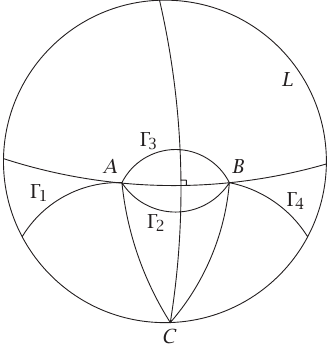
Figure 7.2 . Cutting a possible competitor to the standard double bubble in S n in which all three regions are connected and two intersect the axis of rotation L . (Note that here L is the boundary